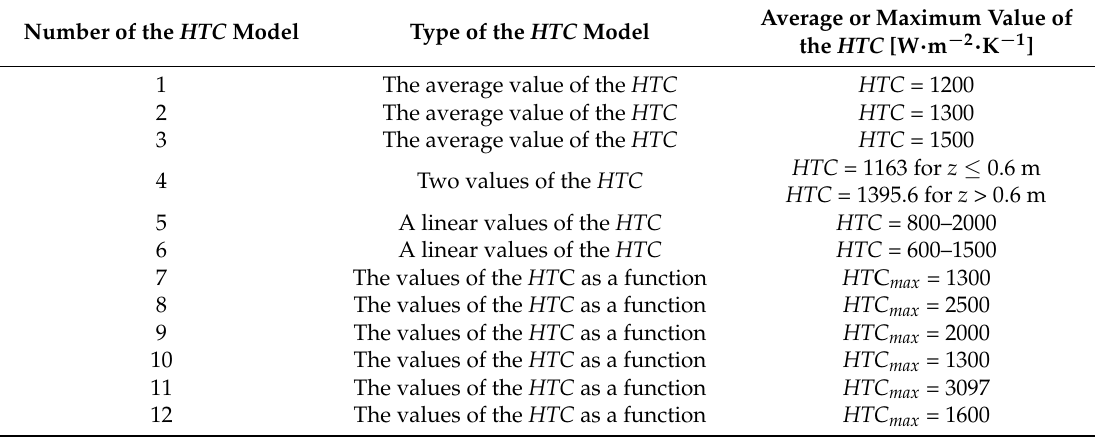
Table 1. The heat transfer coefficient in the primary cooling zone—a comparison of the models (adopted from [6], with permission from Polish Academy of Science,